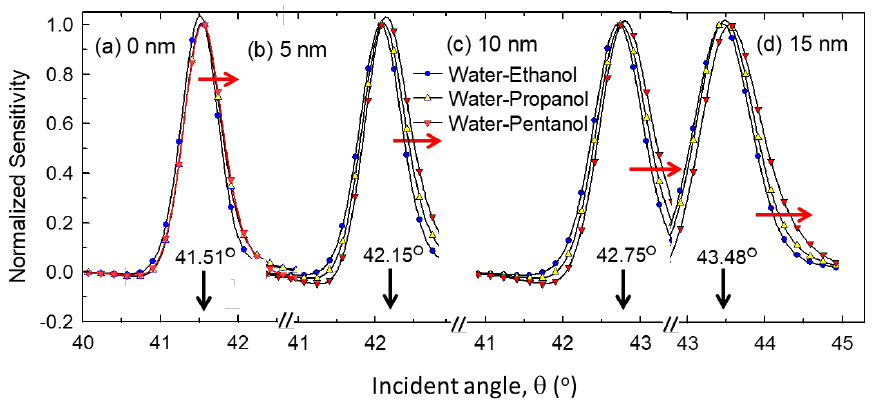
Figure 4. The plot of normalized sensitivity recorded for three different alcohol samples with an increasing refractive index with respect to the water medium. ( a ) Sensor without a protective layer and ( b – d ) sensor with a protective layer, increased from 5 to 15 nm. The vertical black arrows indicate the position of reflectivity minima observed for a pure water medium. The red horizontal arrows indicate the direction of peak shift with refractive index change. Table 1. Optical parameters for water-based media. In column 2, the quantity inside the bracket denotes the thickness of the protective layer, t Pc . In column 3, only the actual sensitivity values calculated for Ti (2 nm)/Au (35 nm)/Co (8 nm)/Au (10 nm)/P c (t pc = 0 nm) multilayer are shown for three different probing samples. The detection noise, σ = 5.0 × 10 − 4 was obtained from the literature [26], and S MOSPR and D denote sensitivity and detection level,